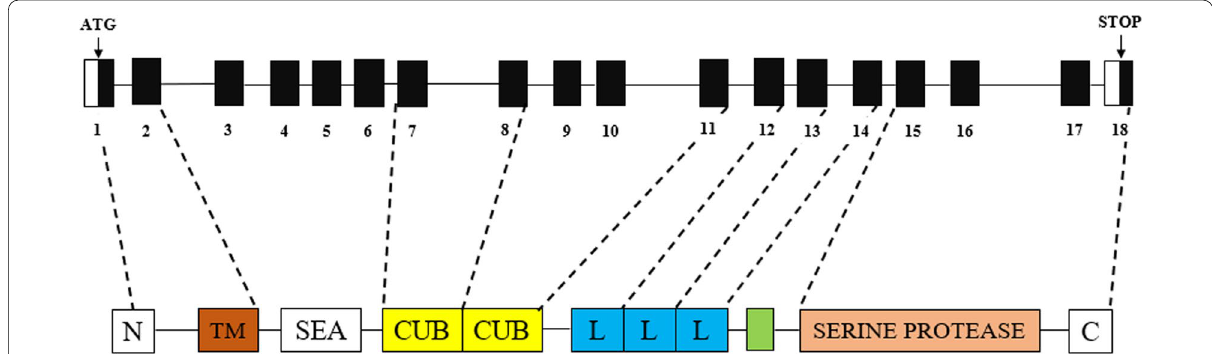
Fig. 1 Structure of TMPRSS6 gene on chromosome 22 and the encoded MT-2 protein domain. The upper panel of the picture shows the TMPRSS6 genomic organisation, with black and white boxes representing coding and non-coding areas, respectively. In the lower panel is the encoded protein. Dashed lines indicate exon encoding boundaries for each of the MT-2 protein structural domains, which include transmembrane (TM), one SEA, two CUBs, three LDL-receptor class A (L), activation (blue box), and trypsin-like serine protease domains (red box)